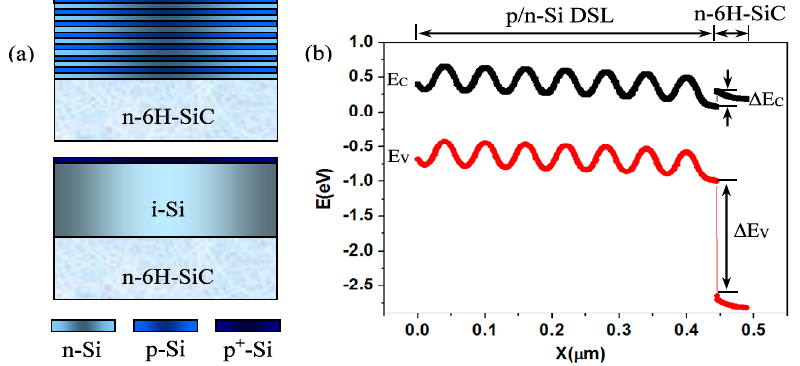
Figure 1. Schematic diagram of p/n-Si DSL and PIN-Si structures on 6H-SiC ( a ); energy-band diagram of p/n-Si DSL structure with seven p/n-Si junctions on 6H-SiC in a thermal equilibrium state ( b ). Δ E C = 0.21 eV, Δ E V = 1.65 eV.